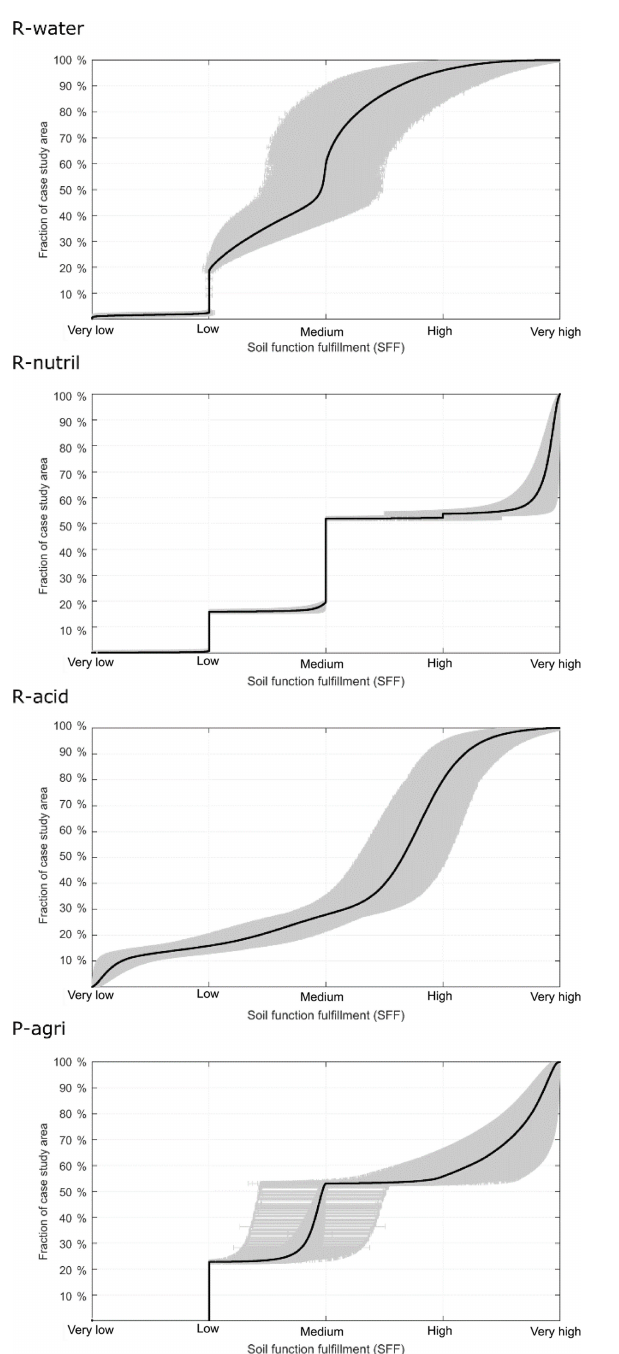
Figure 6. Cumulative distribution function (cdf) of SFF scores for type 2 (look-up table) for R-water, R-nutril, R-acid, and P-agri for agricultural soils of the case study area and the uncertainty resulting from four basic soil properties. SFF score: 1 (very low) to 5 (very high); black: mean SFF score per raster cell; grey: range ± MDM per raster cell, number of raster cells for these soil sub-functions ranged between 420000 and 445000; total area = 170km 2